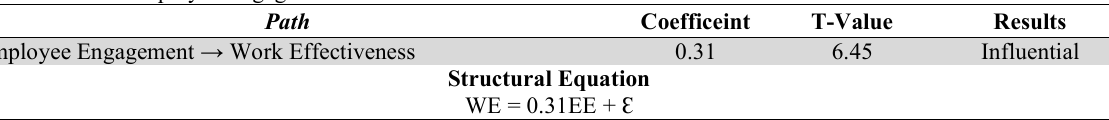
The Influence of Employee Engagement on Work Effectiveness Path Employee Engagement → Work